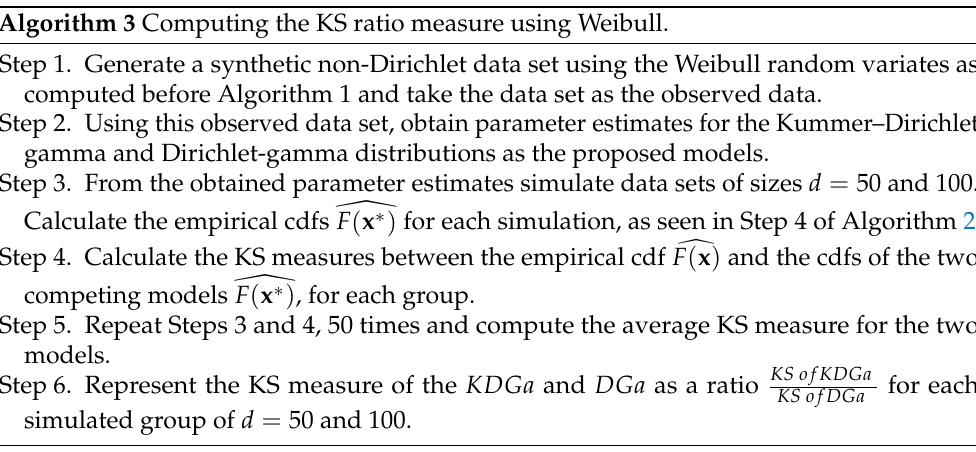
Algorithm 3 Computing the KS ratio measure using